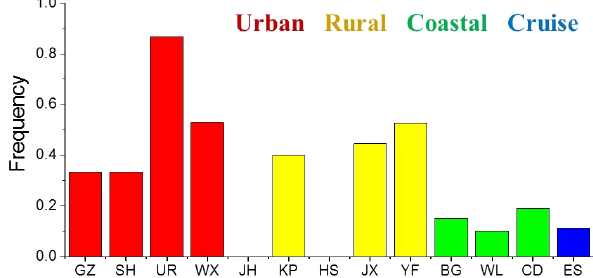
Figure 5. Frequencies of NPF events at different sites. The color of red, yellow, green and blue represent the site type of urban, rural, coastal and cruise,